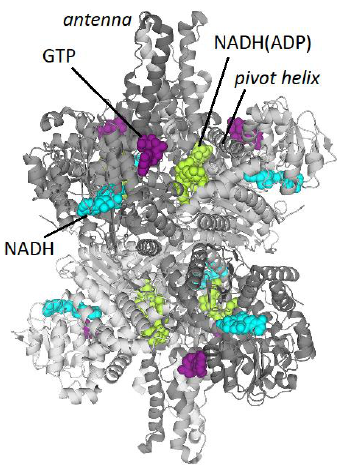
Figure 3. Structure of bovine glutamate dehydrogenase (PDB: 3JD4). Different subunits are shown in different shades of gray. Ligands are presented by space filling models: GTP in the allosteric inhibitory site (purple), NADH in the substrate-binding site (cyan) and NADH in the ADP allosteric site (green).